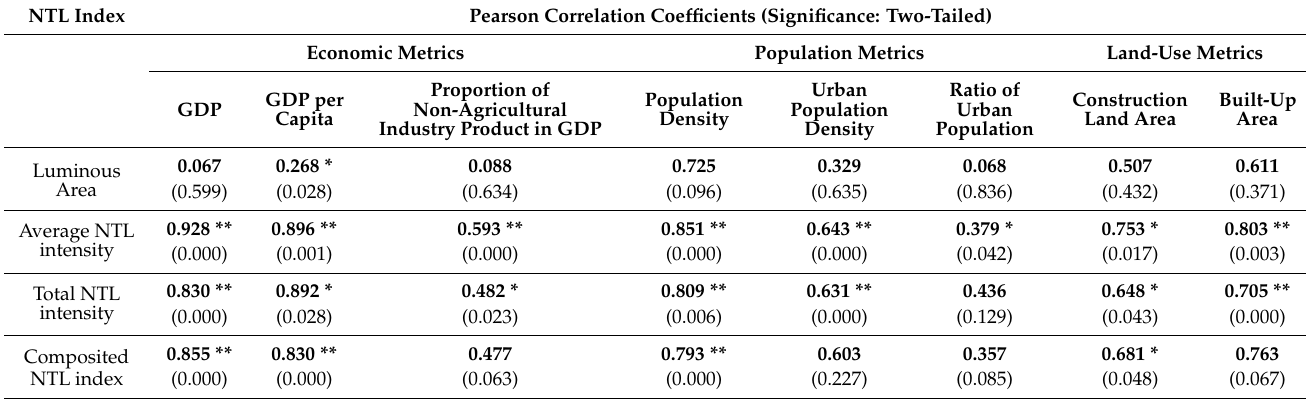
Table 2. Pearson correlation coefficients between the four NTL indexes and the urban statistical data of 2018. NTL Index Pearson Correlation Coefficients (Significance: